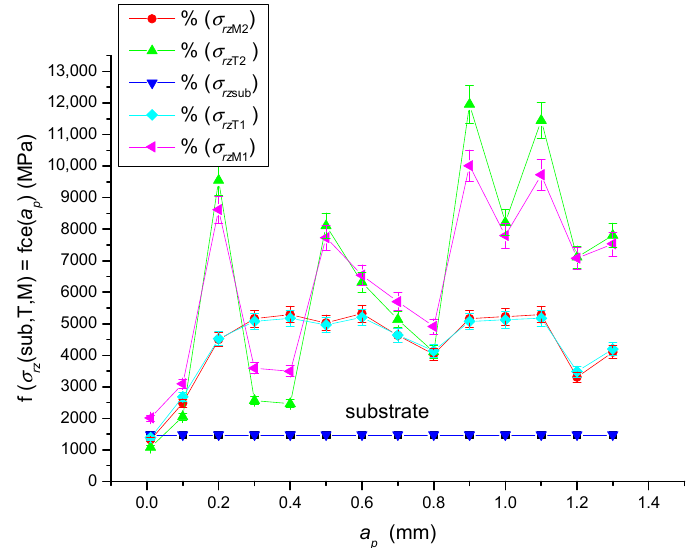
Figure 9. Comparison of stress changes along with the depth of cut a p .